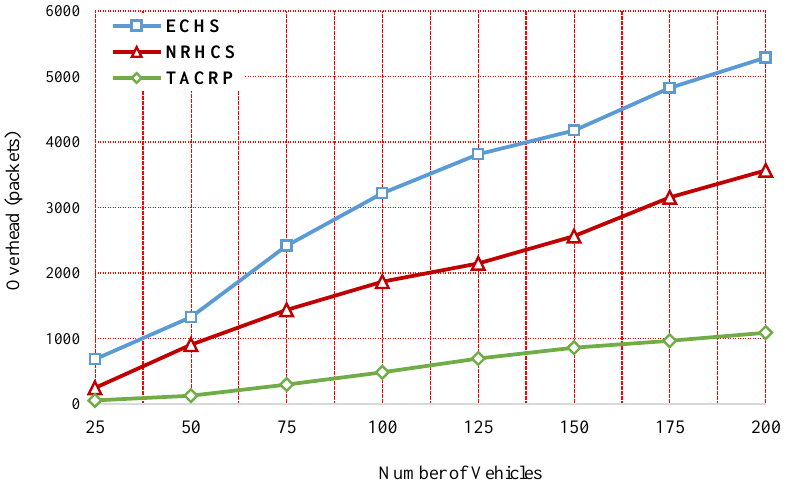
Figure 9. Network Overhead Calculation.